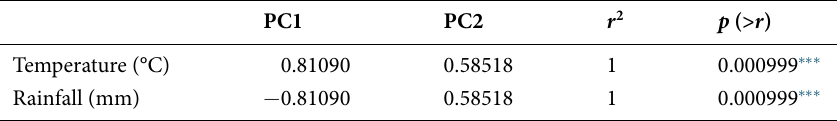
Table 5 Results of principal correspondence